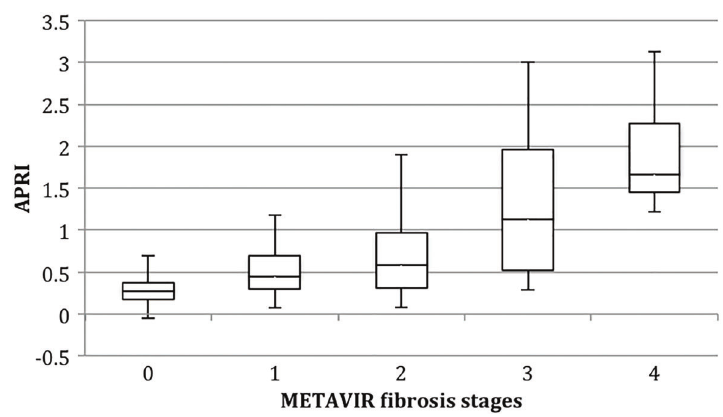
Figure 1. Box plot distribution of aspartate aminotransferase to platelet index (APRI) results according to METAVIR LB staging. First and third quartiles are represented as top and bottom of the boxes, and the error bars show minimum and maximal values. The vertical length of the box represents the interquartile range and the horizon- tal line through the middle represent the median value.